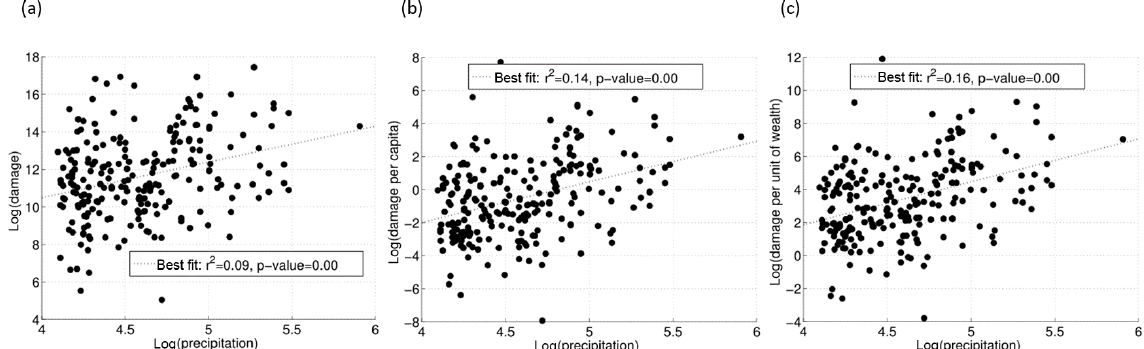
Figure 2. Scatter plot showing maximum precipitation in 24h (mm) and (a) total damages ( D ), (b) damage per capita (DPC), and (c) damage per unit of wealth (DPW), for flood events recorded in Catalonia between 1996 and 2015 (log-transformed values; damages are given in euros). Each point represents the insurance compensation series ( D , DPC or DPW) and the maximum 24h precipitation for each basin. The dashed line indicates the fit based on a linear regression model.